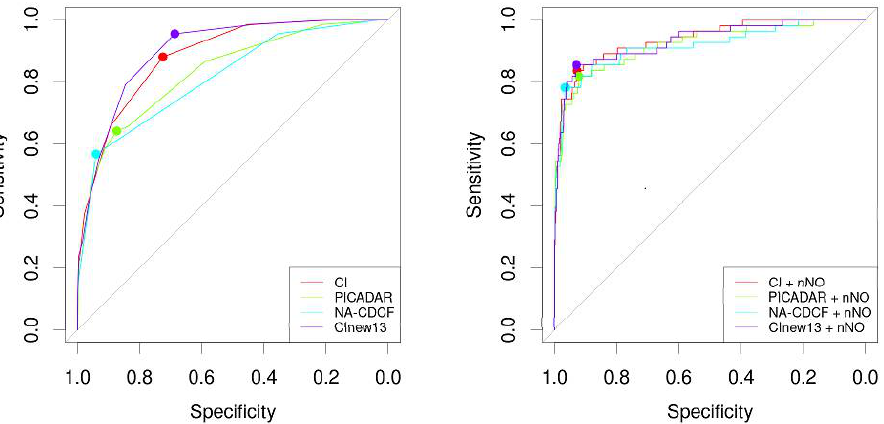
Figure 3. The individual ROC curves of CI, PICADAR, NA-CDCF, and CI new13 without or with nNO measurements. Table 4. Predictive characteristics of the individual tools—CI, PICADAR, NA-CDCF, and CI new13 without or with nNO measurements. Predictive Tool